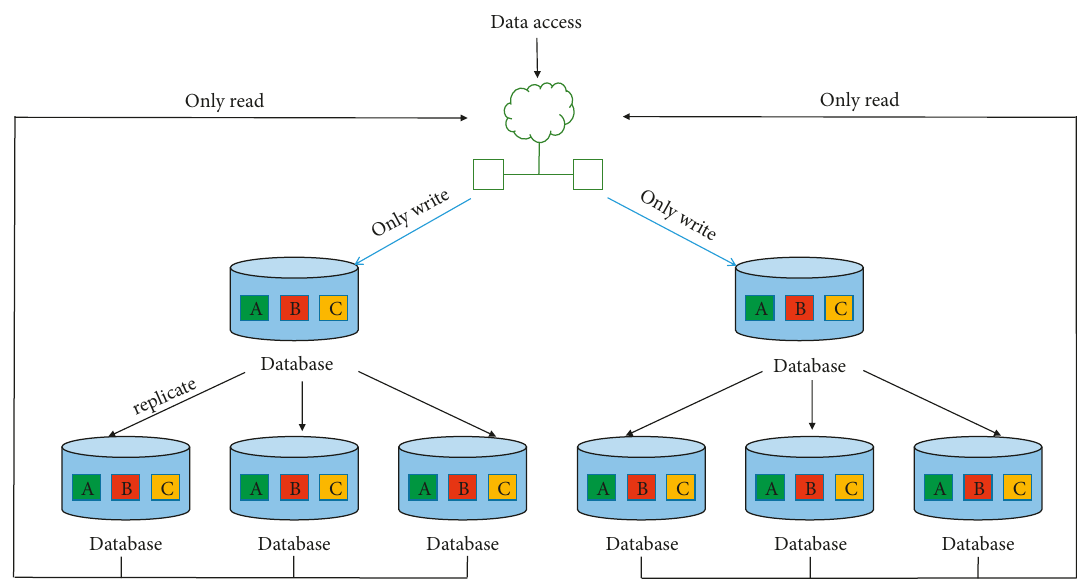
Figure 1: Database infrastructure